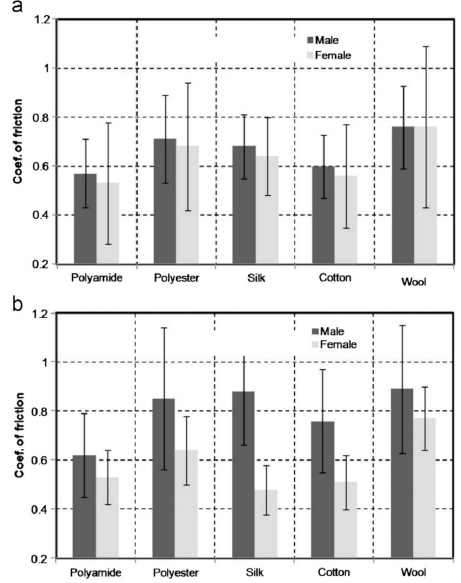
Figure 5. COF against the skin for various fabrics: ( a ) forearm and ( b ) palm [50]. Reproduced with permission from Ramalho, A.; Szekeres, P.; Fernandes, E., Friction and tactile perception of textile fabrics; published by Elsevier,